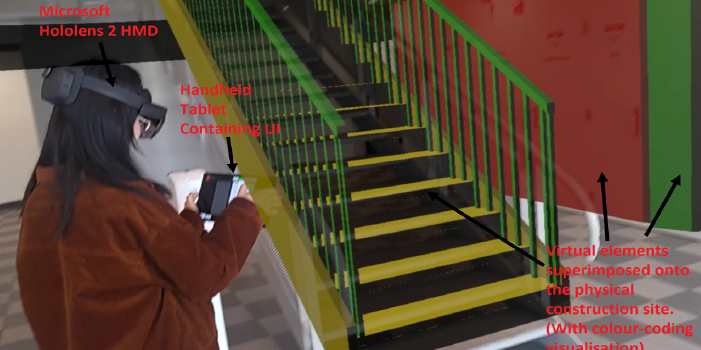
Figure 2. This figure shows a third-person perspective of the BIM-ARDM system. The BIM model is superimposed over the physical site at a one-to-one mapping. A colour-coded visualisation represents correct (green), minor (yellow), and major (red)